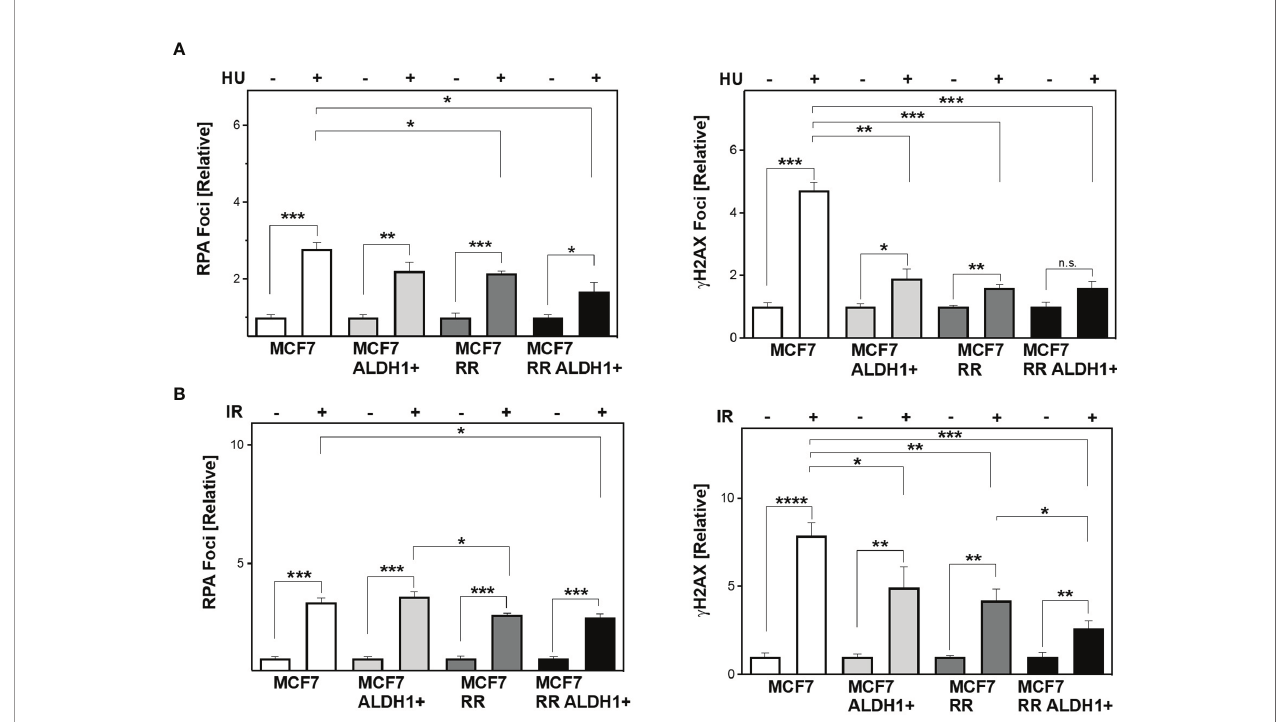
FIGURE 4 | Lower DNA replication stress leads to less DSB in BCSC after treatment. Cells were incubated with HU (A) for 2h or irradiated with 6 Gy (B) . Immunostaining was performed 3h after treatment with a speci fi c antibody against RPA and у H2AX and fl uorescent secondary antibodies. Nuclei were stained with DAPI, quanti fi cation of the foci was performed by automatic foci detection in the Aklides ® -system (Medipan). For each analysis the foci of at least 100 cells were quanti fi ed. Shown are means of three independent experiments ± SEM. Asterisks (*) represent signi fi cant differences (*p < 0.05; **p < 0.01; ***p < 0.001, ****p < 0.0001, Student ’ s